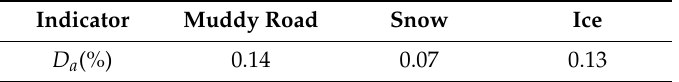
Table 7. The value of amended slip ratio deviation in the